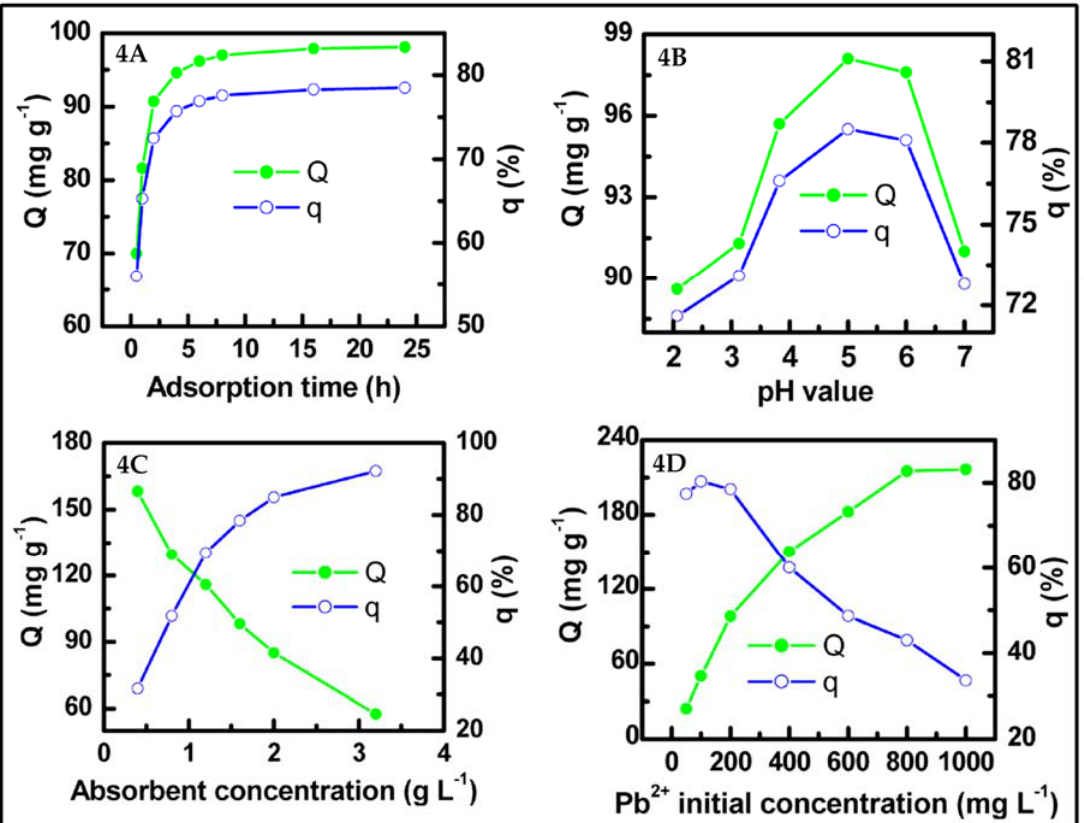
Figure 4. ( A ) E ff ect of contact time vs. adsorption capacity and adsorptivity of LS-GO-PANI adsorbent, ( B ) e ff ect of pH on Pb(II) ions adsorption, ( C ) e ff ect of adsorbent concentration at 200 mg / L initial Pb(II) ions concentration, and ( D ) e ff ect of Pb(II) ions concentration